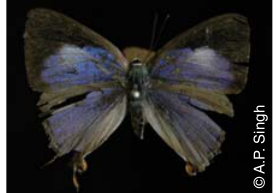
(upper)Image 43. Silver Hairstreak, Chrysozephyrus syla male - 3